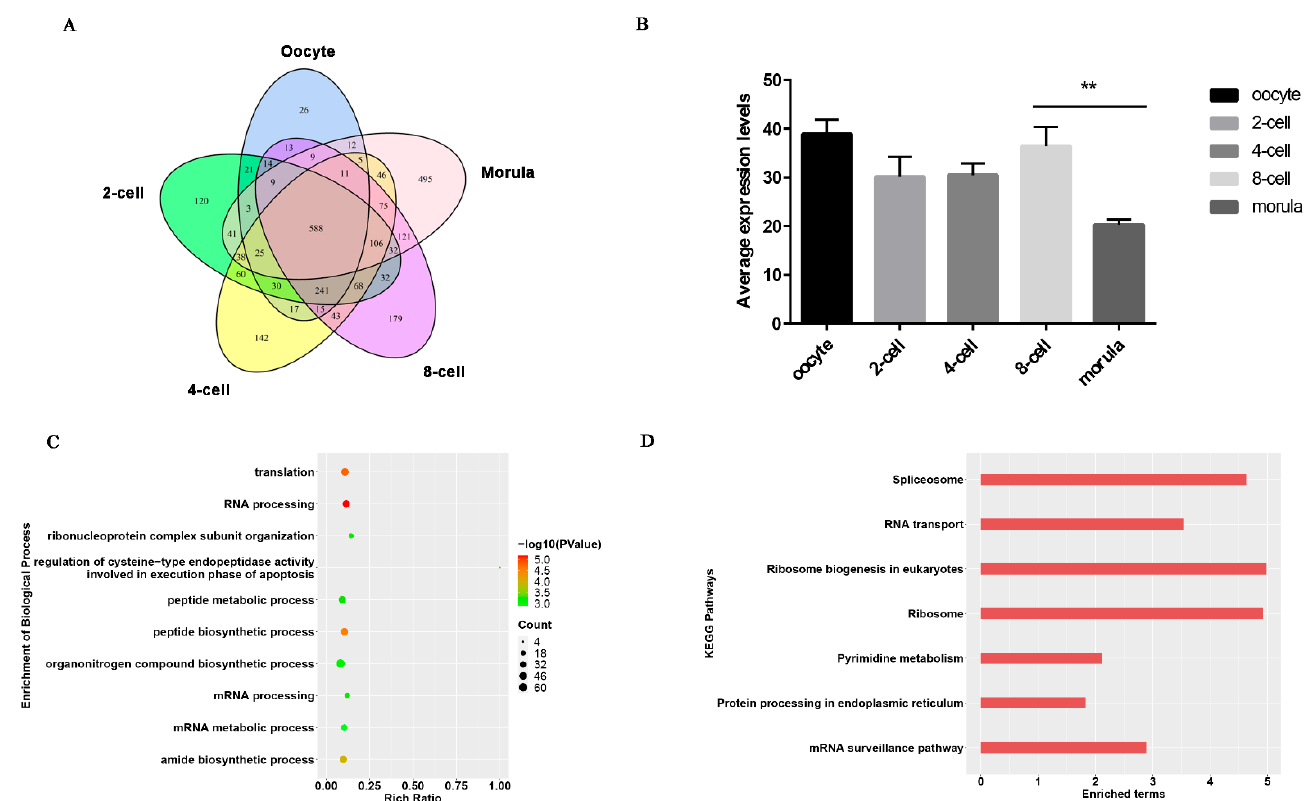
Figure 3. Analysis of maternal lncRNAs. ( A ) Numbers of lncRNAs expressed in each stage. ( B ) Average expression levels of 588 maternal lncRNAs; **—indicates statistically significant with p < 0.01. ( C , D ) GO and KEGG analyses of maternal lncRNAs ( p < 0.05).